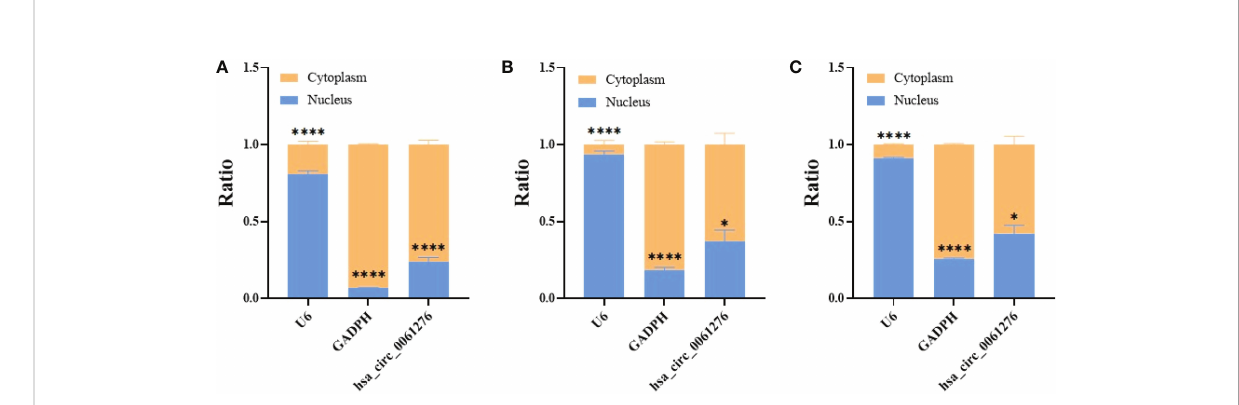
FIGURE 4 Distribution of hsa_circ_0061276 in cell fractions. qRT-PCR was used to detect the level of hsa_circ_0061276 in the nuclear and cytoplasmic fractions of 293T (A) , AGS (B) , and HGC-27 (C) cell lines. * p < 0.05, **** p < 0.0001, n = 3. Independent samples t -test